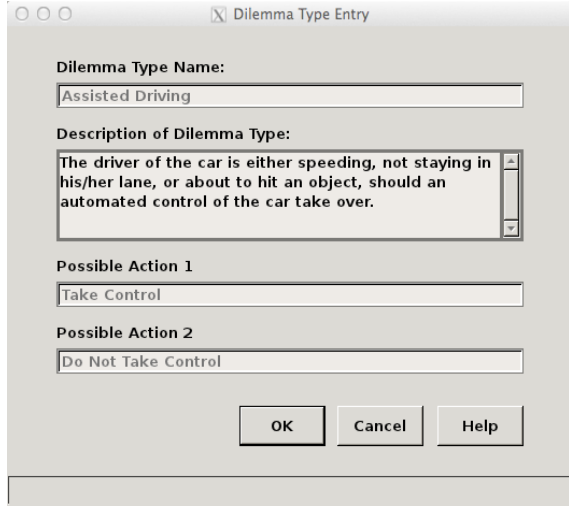
Figure 1: GenEth dilemma type dialogue used to input information concerning the dilemma type under investigation.